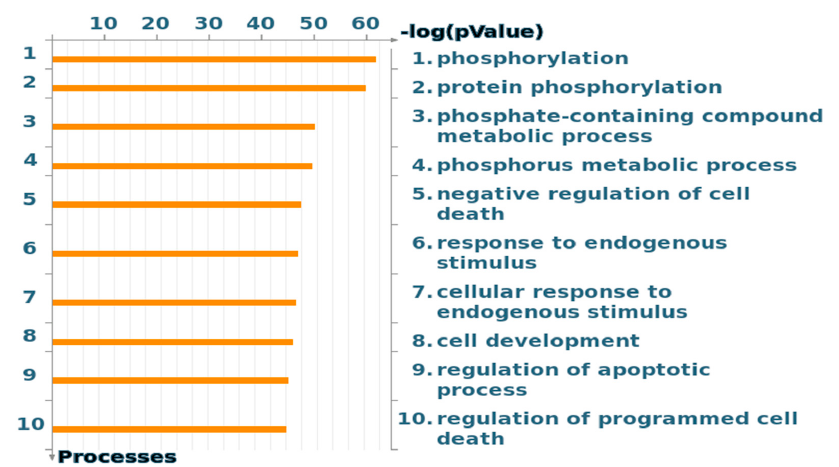
Figure 3. Gene ontology (GO) processes, sorted by statistically significant processes.